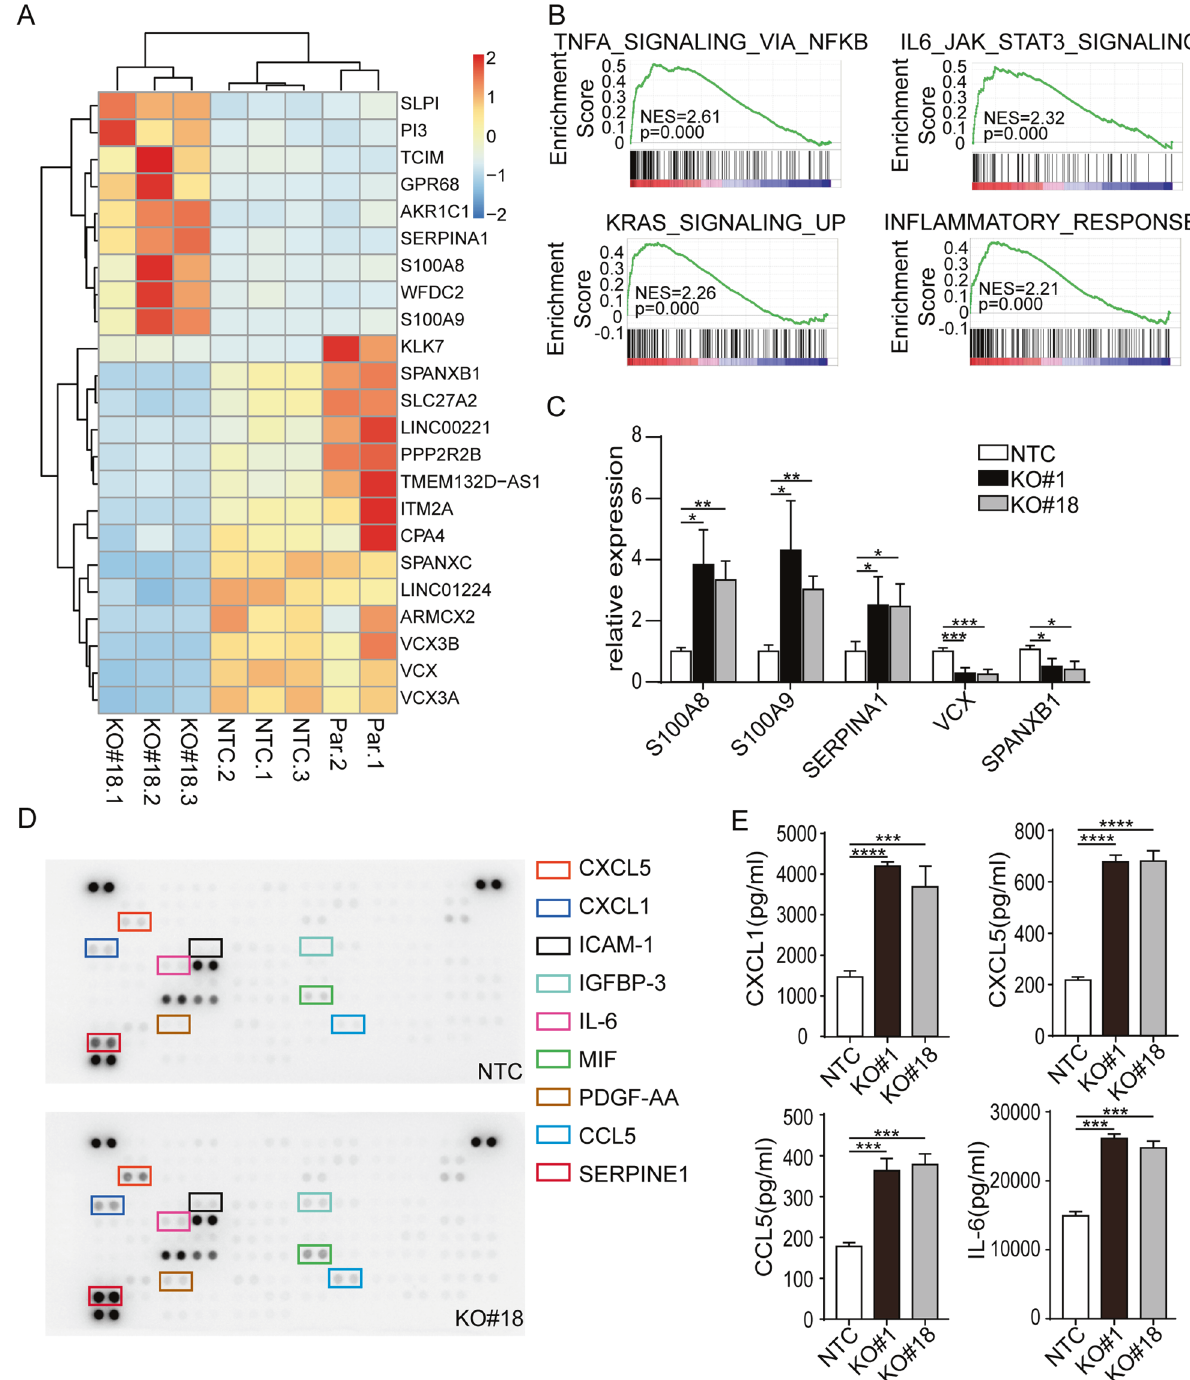
Fig. 6 ILK loss-induced senescence exhibited in fl ammation-associated transcriptomic patterns in MKN1. A Heatmap displaying the most signi fi cantly differentially changed genes at RNA expression levels analyzed by RNA sequencing for NTC, ILK-KO #18 and parental MKN1 cells (adjusted p value <0.05, absolute logFC>1). B Gene set enrichment analysis (GSEA) identifying distinct pathways and biological processes between MKN1 NTC and #18 based on hallmark gene sets (h.all.v5.1.symbols.gmt). NES, normalized enrichment score. The top 4 enriched hallmark gene sets are shown as an example of maximum possible enrichment. C The alteration of selected genes expression was validated in NTC, #1 and #18 clones by qPCR analysis. D Cytokine antibody array was performed in the culture medium of MKN1 NTC and #18 according to the protocol from the manufacturer. Signi fi cantly changed cytokines in the absence of ILK ablation were shown on the right. Four selected cytokines were validated by ELISA E . Data represent the mean ± SD of at least three independent experiments. * p < 0.05, ** p < 0.01, *** p < 0.001, **** p <